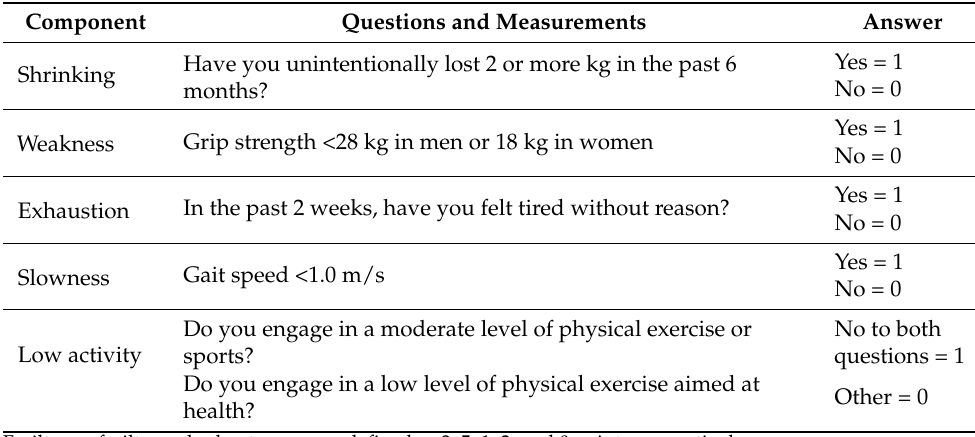
Table 1. The revised Japanese version of the Cardiovascular Health Study (J-CHS) criteria, created based on a reference from Satake et al.